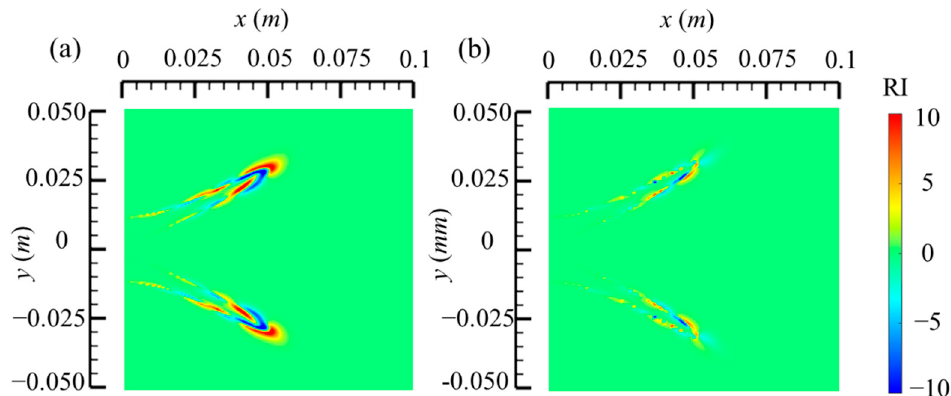
Figure 17. Local Rayleigh Index distribution: ( a ) T H = 500 K and ( b ) T H = 1800 K, where S N = 0.45, V a = 180 L/min and T i = 300 K.